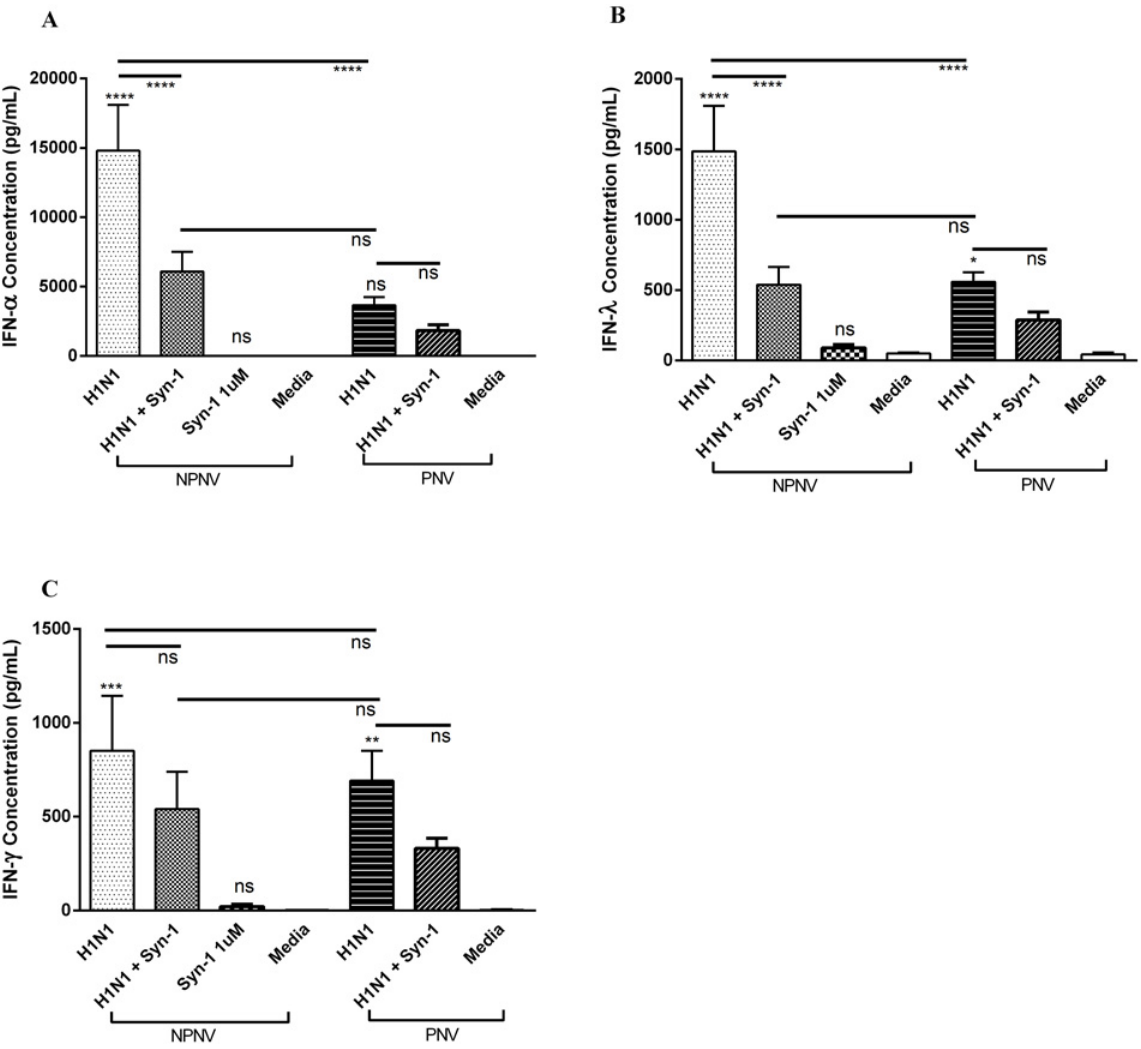
Fig 1. PBMCs from non-pregnant women have a robust IFN response to H1N1pdm09. The response of PBMCs from pregnant and non-pregnant women to H1N1pdm09 was assessed after 48 hours of exposure. PBMCs from non-pregnant women were pre-exposed to syncytin-1 (1 μ M). PBMCs were infected with H1N1 MOI 0.1 for 48hrs. Levels of IFN- α (A), IFN- λ (B) and IFN- γ (C) in cell culture supernatants were measured by cytometric bead array (IFN- α and IFN- γ ) or ELISA (IFN- λ ). NPNV = Non-pregnant and non-vaccinated n = 10, PNV = Pregnant and non-vaccinated n = 12. ANOVA (Holm-Sidak) **** P < 0.0001, *** P < 0.001, ** P < 0.01, * P <